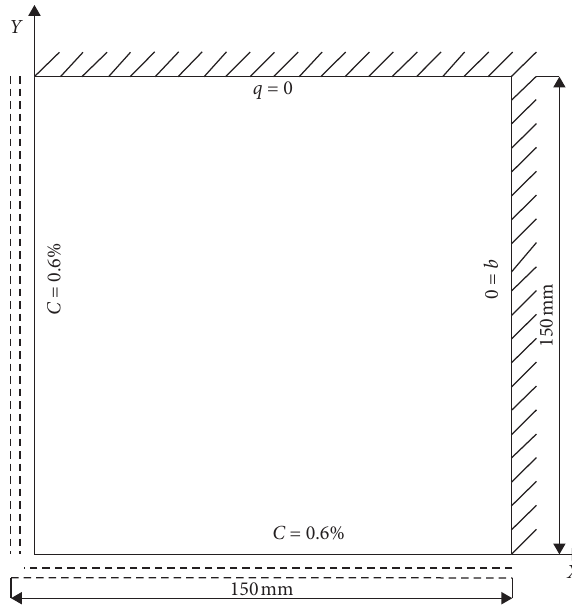
Figure 4: 2D concrete